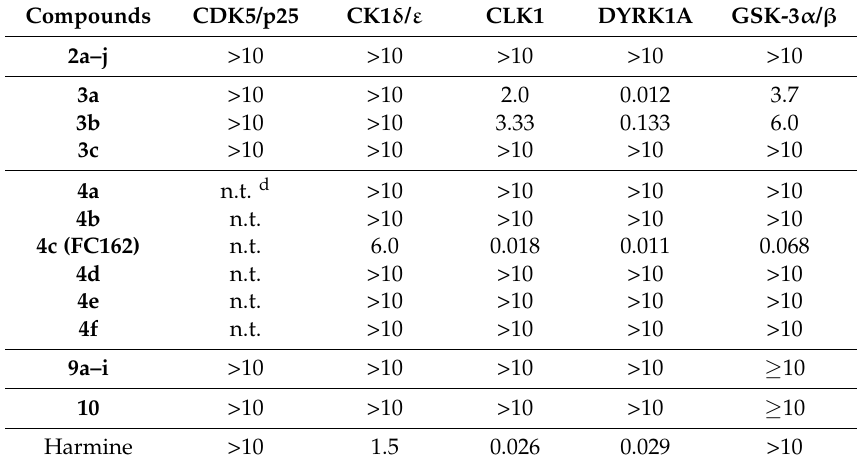
Table 4. Kinase inhibitory activity a,b,c of the thiazolo[5,4- f ]quinazolin- series ( 2a – j , 3a – c , 4a – i , and 10 ). Compounds CDK5/p25 CK1 δ /